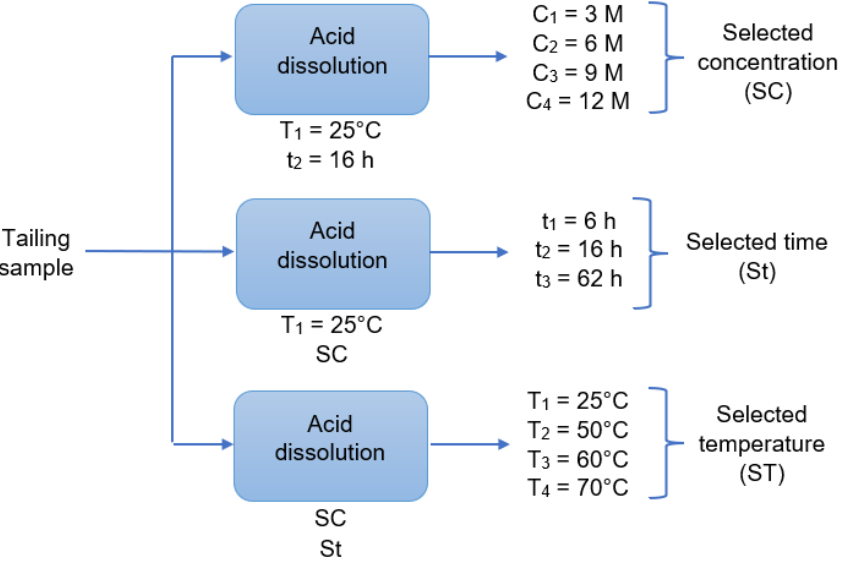
Figure 2. Proposed method for acid dissolution.